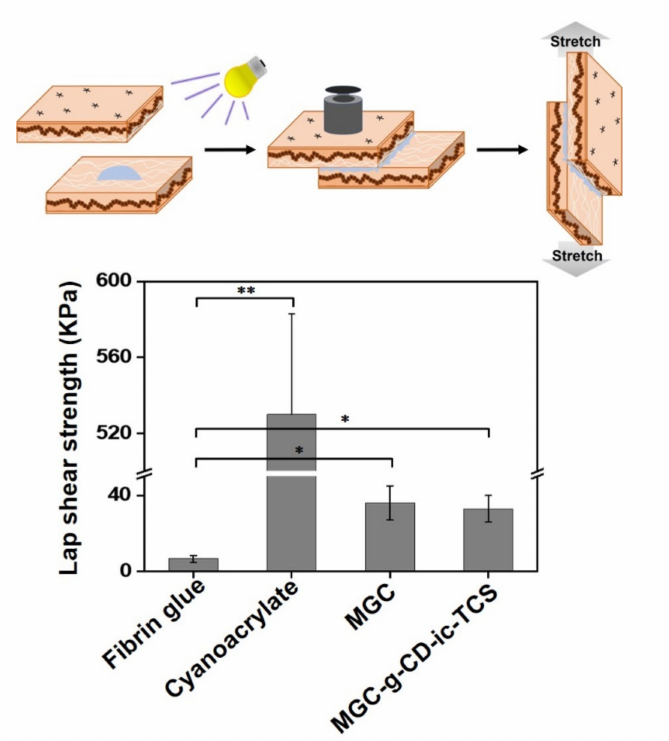
Figure 6. Lap shear strength of fibrin glue, cyanoacrylate, MGC, and MGC-g-CD-TCS. This test was performed in triplicate ( n = 3; * p < 0.05, ** p <